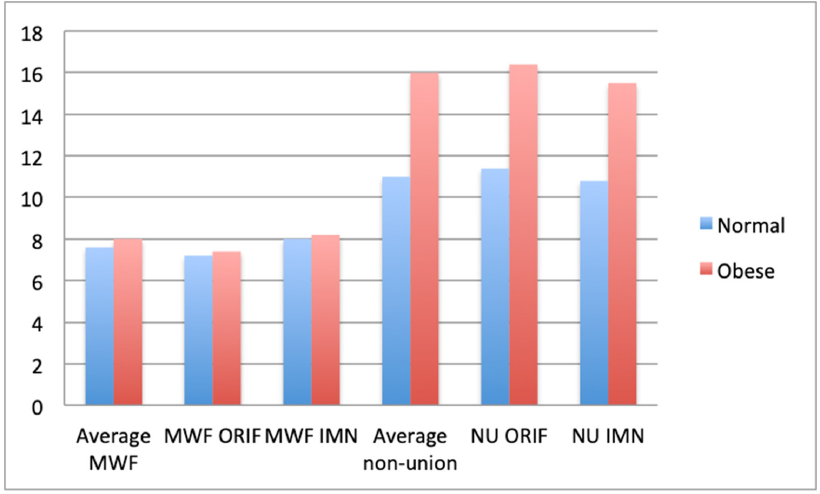
Figure 5. Comparison of % of normal and obese patients requiring reintervention for metal work failure or non ‐ union, averages and surgical specific (MWF = metal work failure; NU= non ‐ union; ORIF = open reduction and internal fixation; IMN = intramedullary